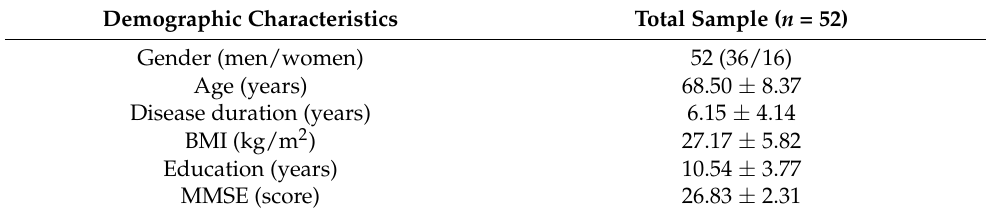
Table 1. Demographic